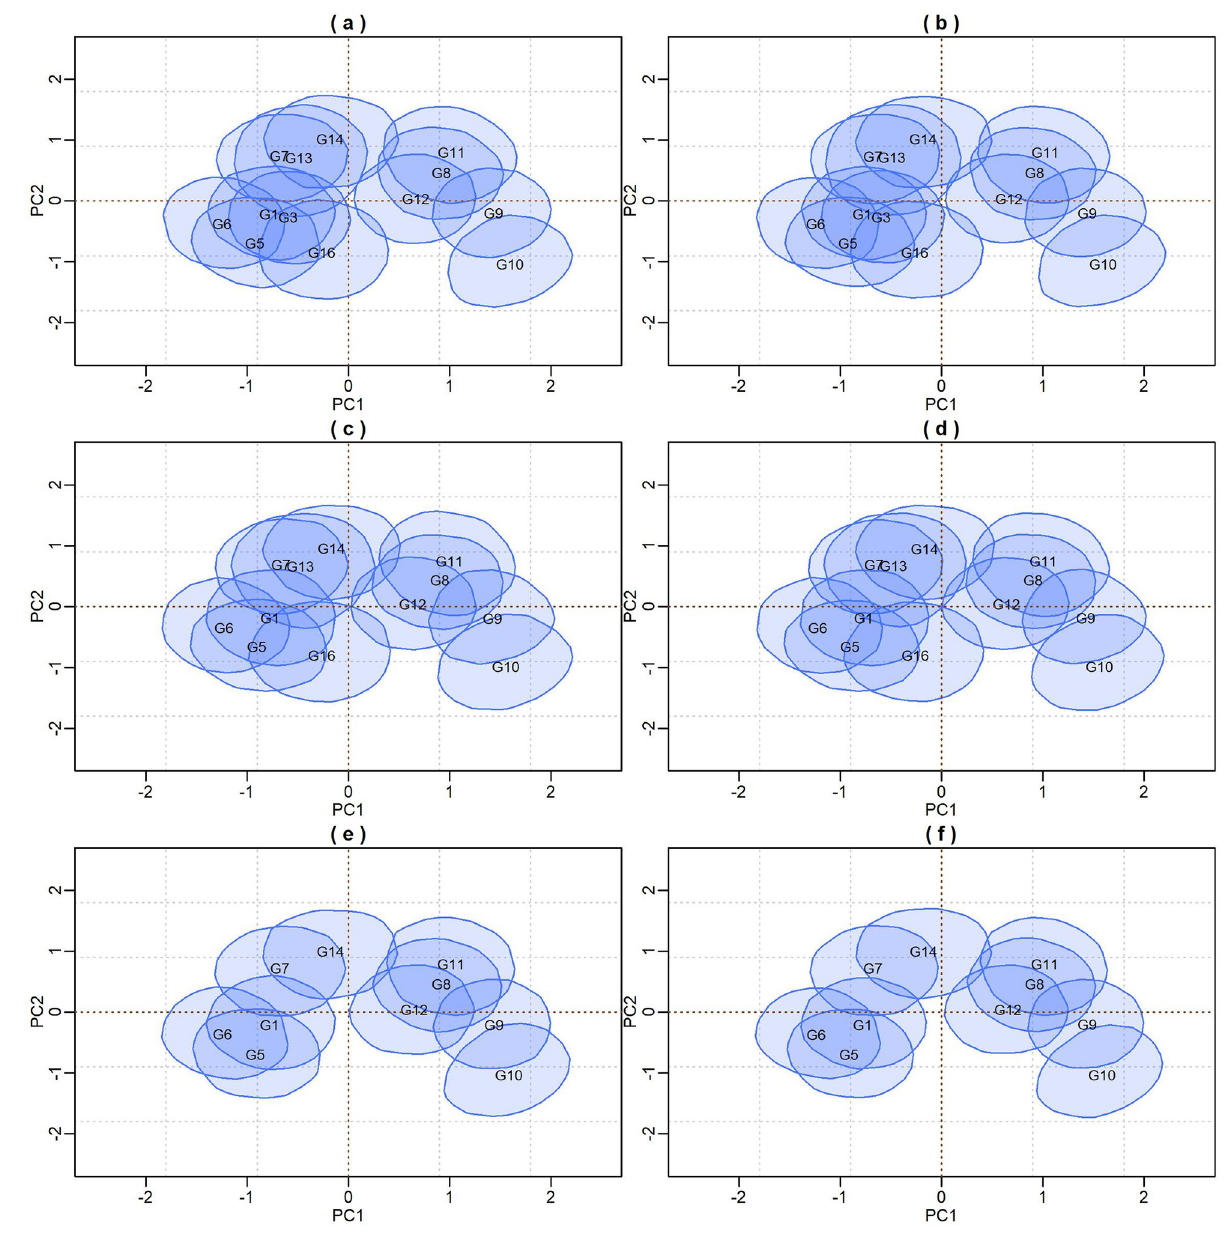
Fig 4. Representations of the bivariate credibility regions at 95% probability, based on the marginal and conditional response of the BAMMI, BAMMIS, and BAMMIE, models.